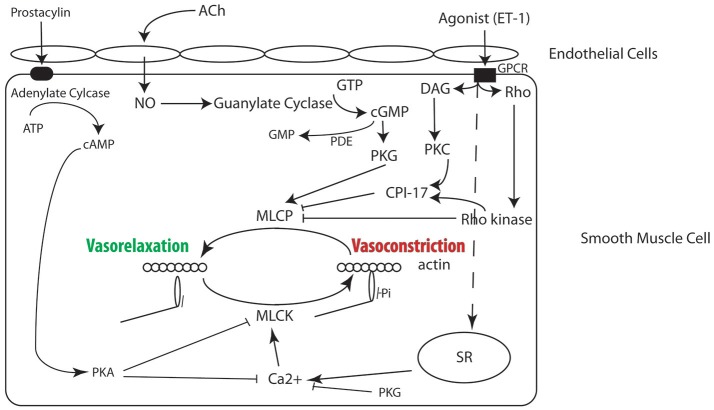
Signaling pathways in smooth muscle regulating contractility, many of which have been implicated in the molecular mechanism for PAH and are the target of therapy (see text for details).